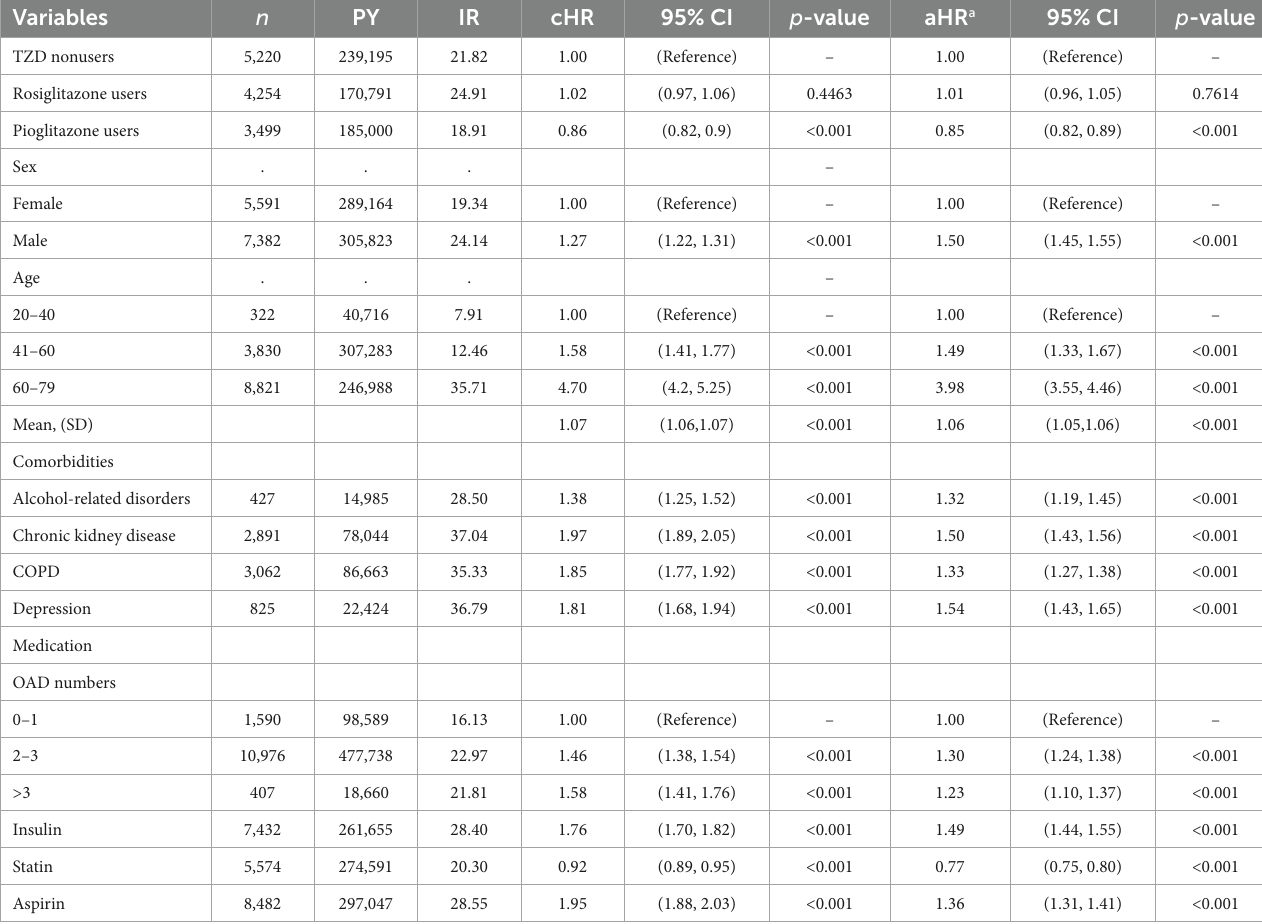
TABLE 3 Risk of hospitalization for all-cause pneumonia in patients with T2D stratified by variables. Variables